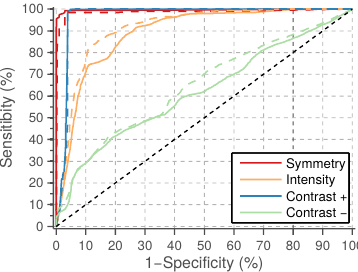
Figure 10. Receiver operating characteristic (ROC) curves for the eight one-dimensional classifiers used for feature-based lumen candidate selection. Solid lines represent line features. Dashed lines represent band features.